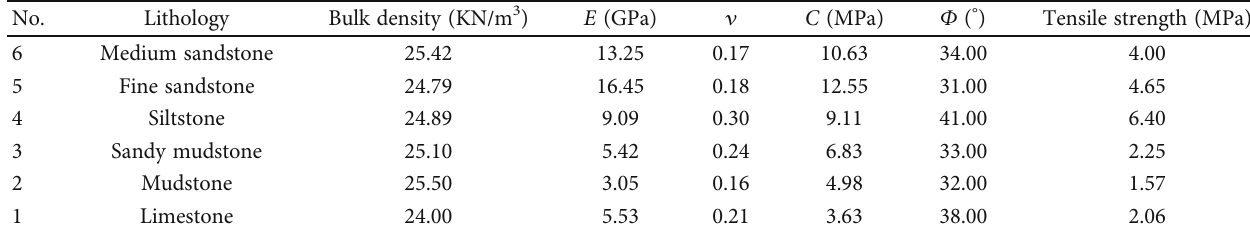
Table 2: Physical and mechanical parameters of coal and rock mass.